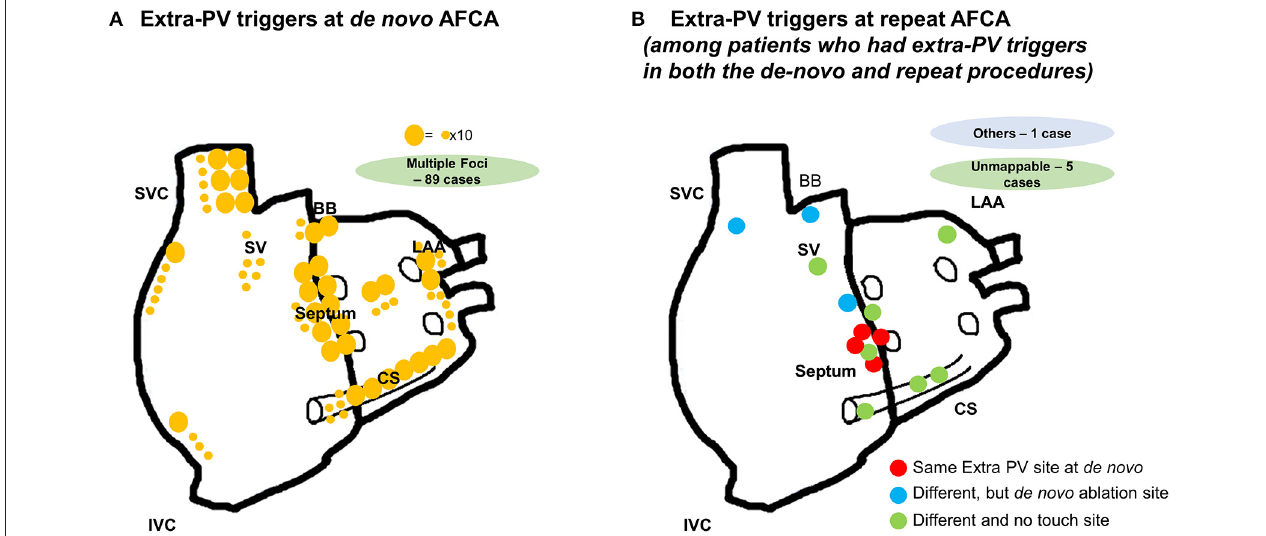
FIGURE 2 | Locations of the extra-PV triggers (A) during the de novo AFCA; (B) during the repeat AFCA in patients who had both extra-PV triggers in the de novo and repeat AFCA.